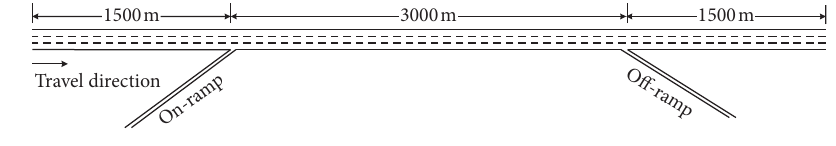
Figure 1: Simulated freeway network diagram. Table 3: Simulation scenarios of traffic